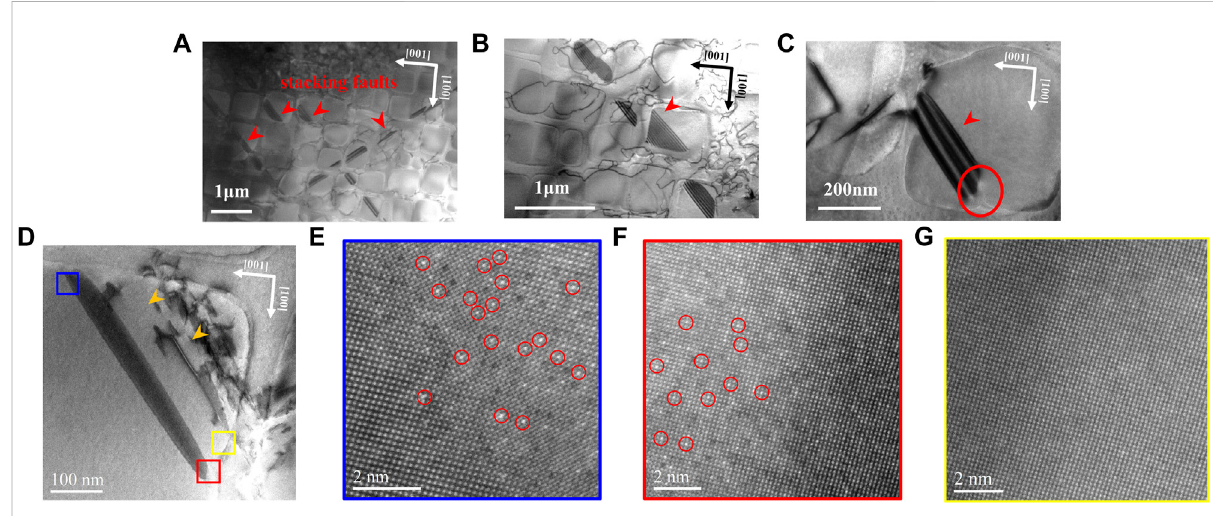
FIGURE 6 (A – D) Stacking fault morphologies at point C of the blade, (E – F) STEM images of the stacking fault at the atomic level, (G) STEM images of γ ′ precipitate at the atomic